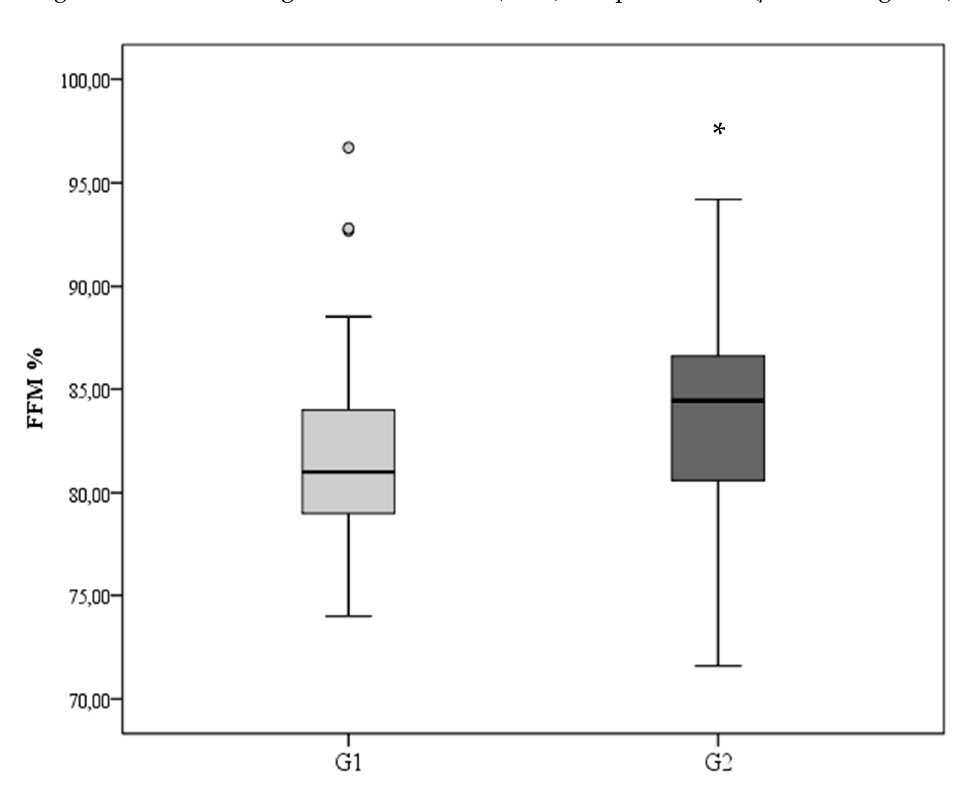
Figure 1. Body composition at TCA in term of Fat Free Mass (FFM) %. * G2 vs. G1; p = 0.04.